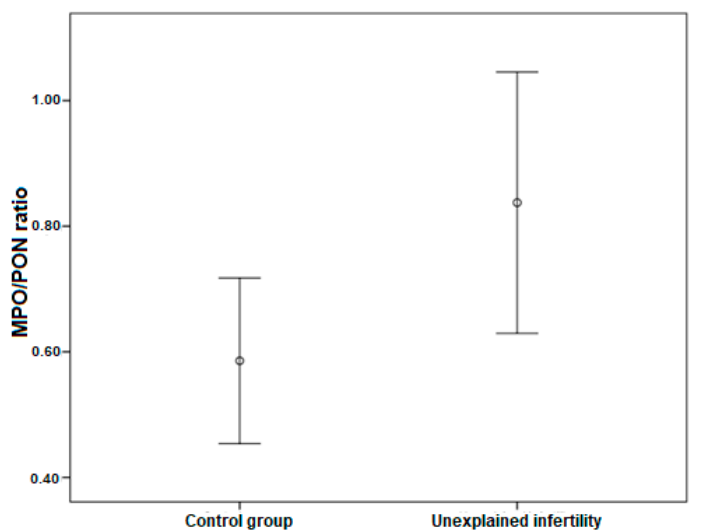
Figure 2. The alteration of serum MPO/PON ratio in control and unexplained infertility groups ( x ± σ x ).